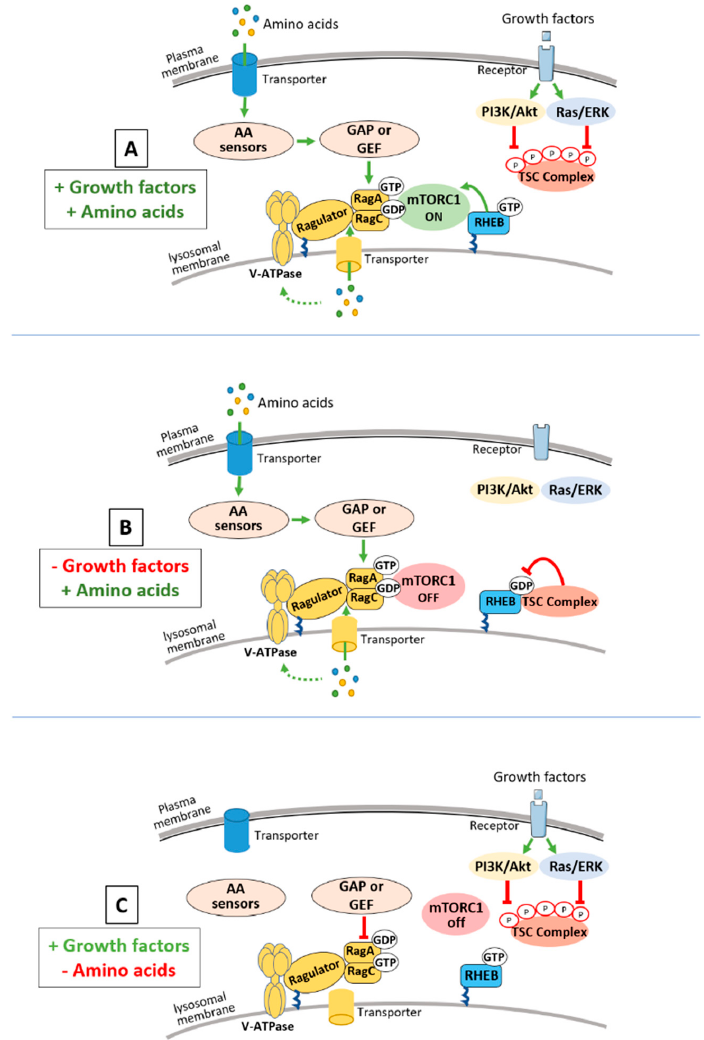
Figure 1. Mechanistic target of rapamycin complex 1 (mTORC1) integrates signals from growth factors and amino acids. This schematic represents different nucleotide loaded states of the Rheb and Rags GTPases in the presence or absence of amino acid (AA) and Growth factors and their influence on mTORC1 activity. ( A ) The presence of growth factors and hormones leads to an Akt- or Erk-dependent phosphorylation of tuberous sclerosis complex (TSC), resulting in the immediate release of the TSC complex from the lysosome promoting the accumulation of Rheb-GTP and therefore mTORC1 activation. ( B ) During a cellular stress or growth factors withdrawal, the TSC complex is recruited to the lysosome where it decreases Rheb-GTP levels and turns off mTORC1 signaling. AAs are sensed via a complex upstream network composed of AA sensors, AA transporters and GAP and GTP exchange factors (GEFs) factors that regulate the nucleotide loaded state of RagA/B and RagC/D. When AAs are present, the Rag heterodimer is converted to its active conformation, RagA/B-GTP and RagC/D-GDP, which leads to the lysosomal recruitment of mTORC1. (Panel C ) When AAs are absent, the Rag heterodimer is converted to its inactive conformation RagA/B-GDP and RagC/D-GTP which promotes the release of mTORC1 into the cytoplasm ( C ). Signals from both AAs and growth factors/hormones are required to promote a full activation of